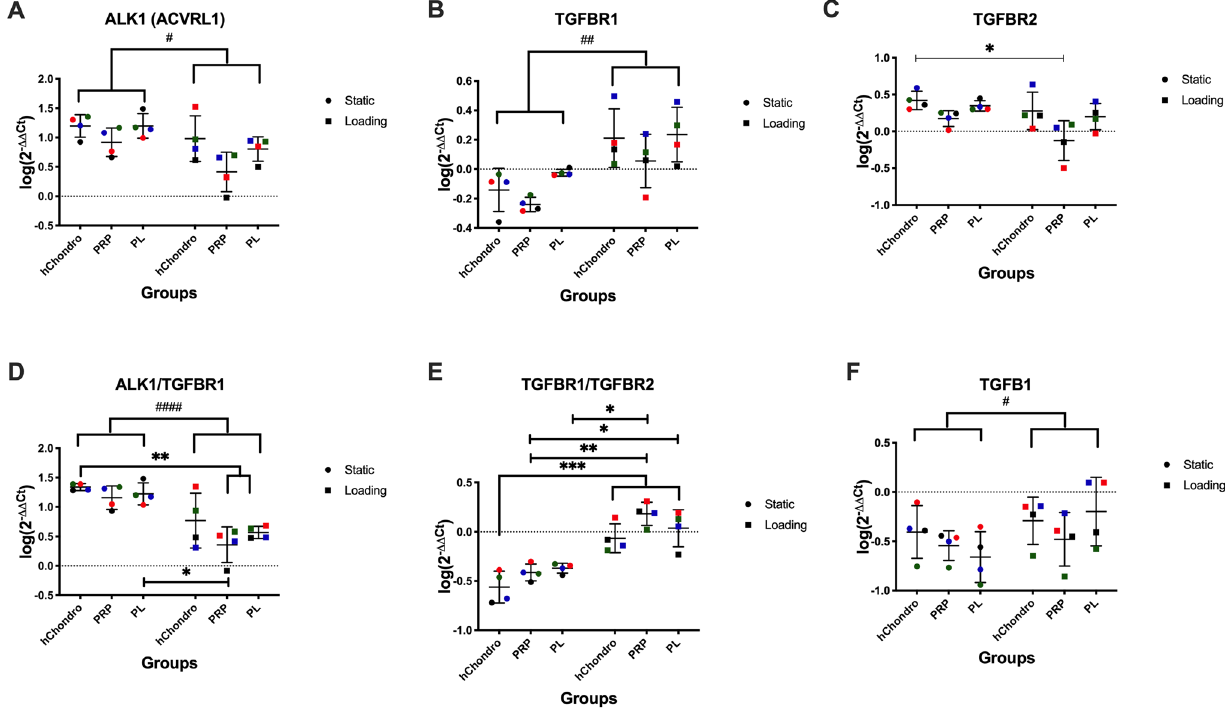
gene expression (log(2 −ΔΔCT )) was transformed by log(10) and visualized in scatter dot plots with different